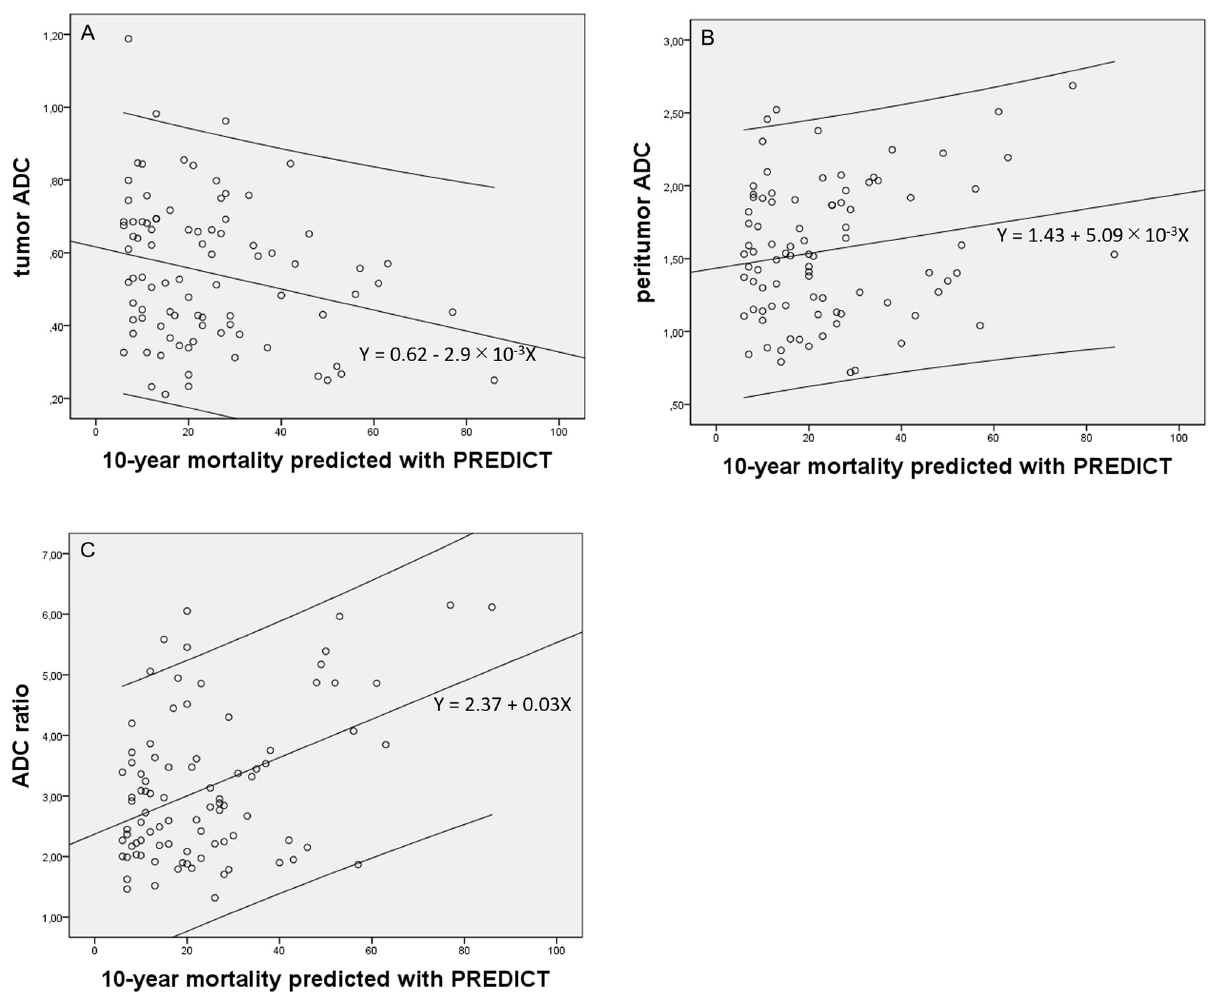
Fig 6. Scatterplots of tumor and peritumor apparent diffusion coefficient (ADC) values and peritumor/tumor ADC ratios against mortality predicted with PREDICT. Regression lines and 95% confidence intervals are shown. A, tumor ADC values against mortality predicted with PREDICT ( r = − 0.250, p = 0.019); B, peritumor ADC values against mortality predicted with PREDICT ( r = 0.187, p = 0.081); C, peritumor/tumor ADC ratios against mortality predicted with PREDICT ( r = 0.436, p <